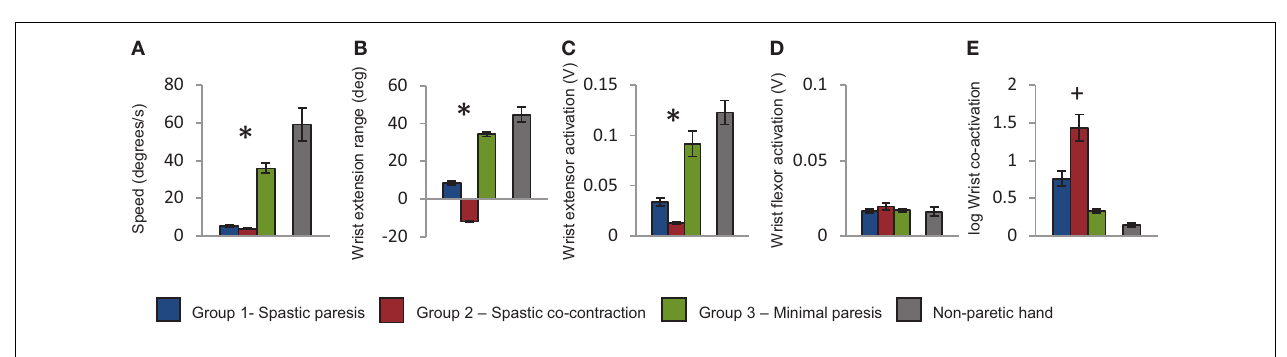
Fugl-Meyer scores, the red bars represent the spastic co-contraction group with intermediate Fugl-Meyer scores, and the green bars represent the minimal paresis group, which had the highest Fugl-Meyer scores. Values for the non-paretic hand are shown in gray for reference. Error bars represent the standard error. *Represents differences between the three groups at p < 0.05, and + represents differences between the three groups at p <